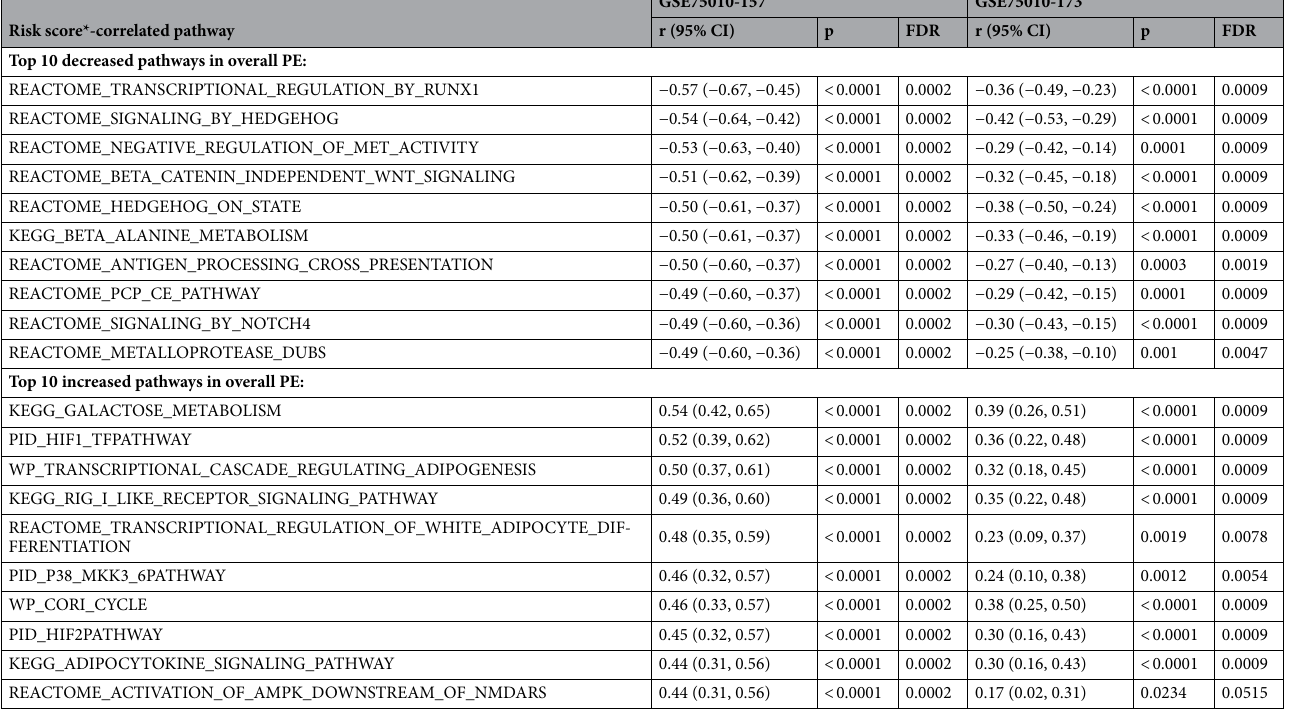
Table 3. Top 10 pathways correlated with CRY1, NR1D2 and PER3 -based risk score in placenta (overall PE vs. overall non-PE) in two independent datasets (cut-off: p < 0.05 and FDR < 0.10). *Risk score = CRY1 + (11- NR1D2 ) + (9- PER3 ).